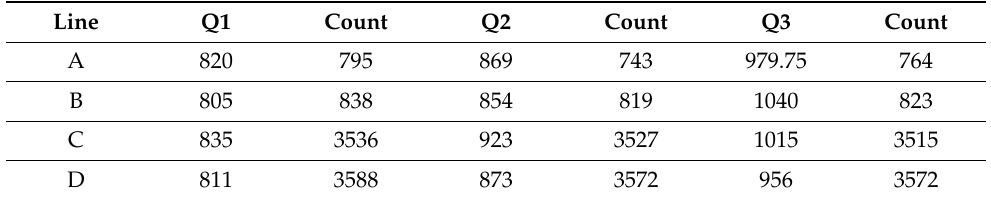
Table 7. Quartiles and number of observations for each line.